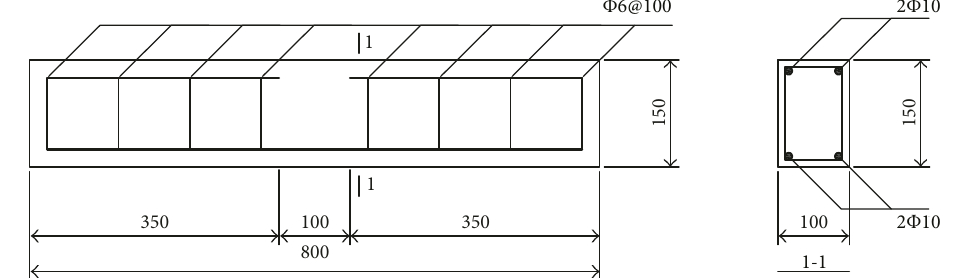
Figure 1: Geometry size and reinforcement of beam specimens.